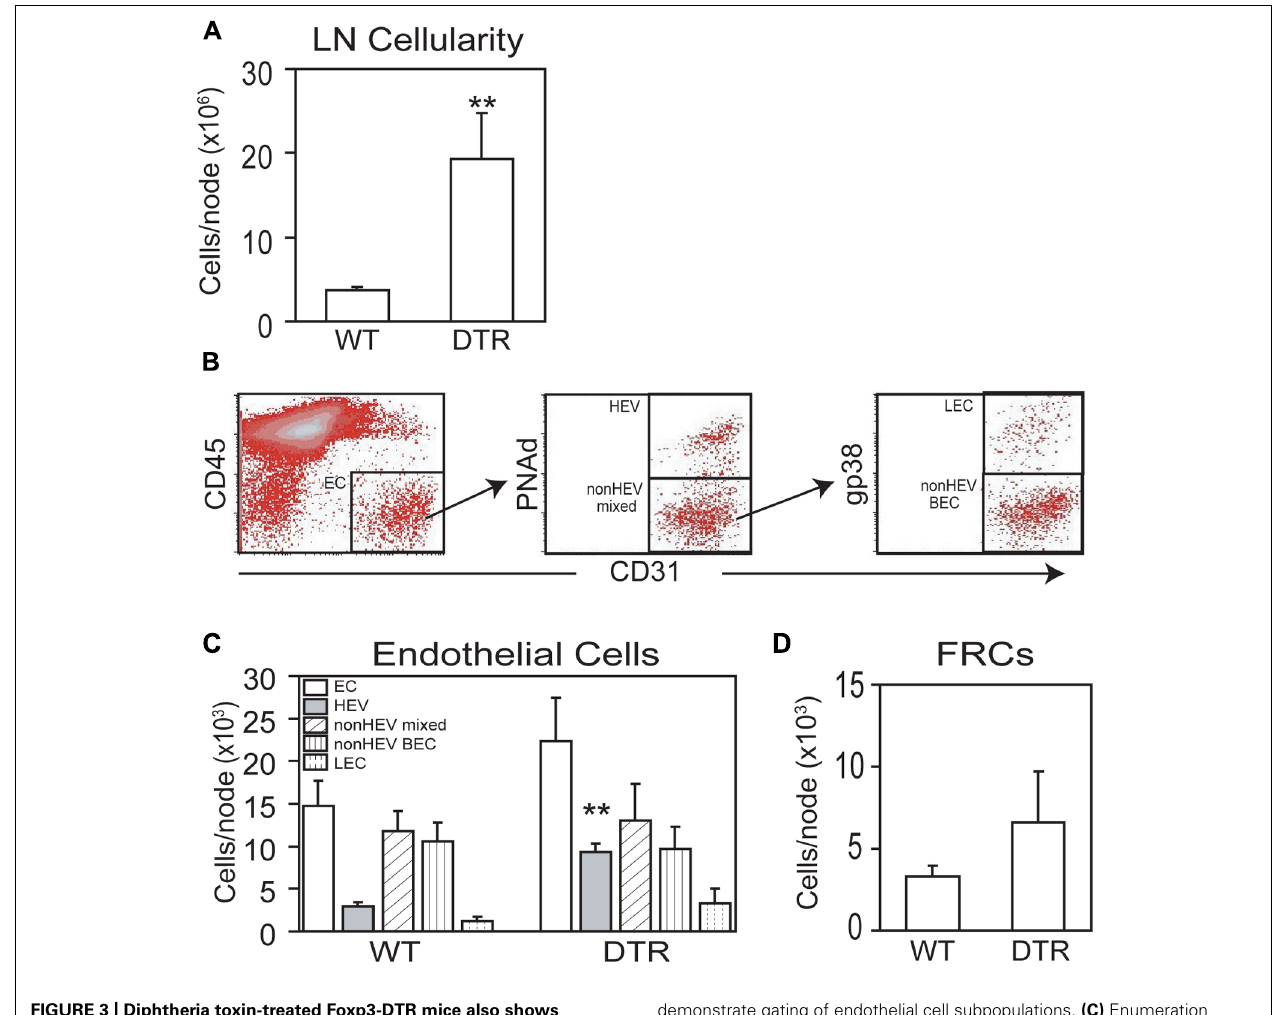
FIGURE 3 | Diphtheria toxin-treated Foxp3-DTR mice also shows more generalized lymph node vascular–stromal growth. Wild-type (WT) and Foxp3-DTR (DTR) mice were injected with DT as per Section “Materials and Methods” and brachial lymph nodes were analyzed by flow cytometry. (A) Lymph node cellularity. (B) Flow cytometry plots to